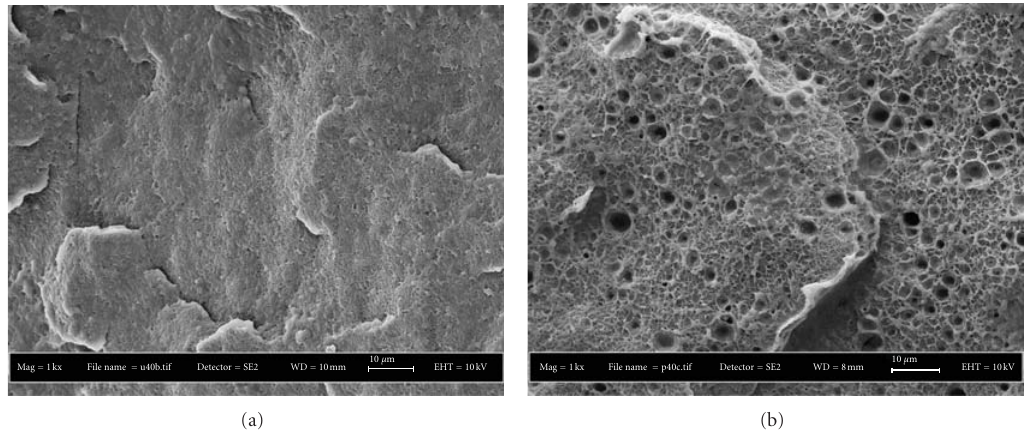
Figure 6: Fracture surfaces of (a) UHMWPE/HDPE (40/60) blend and (b) UHMWPE/HDPE (40/60) blend containing 2phr